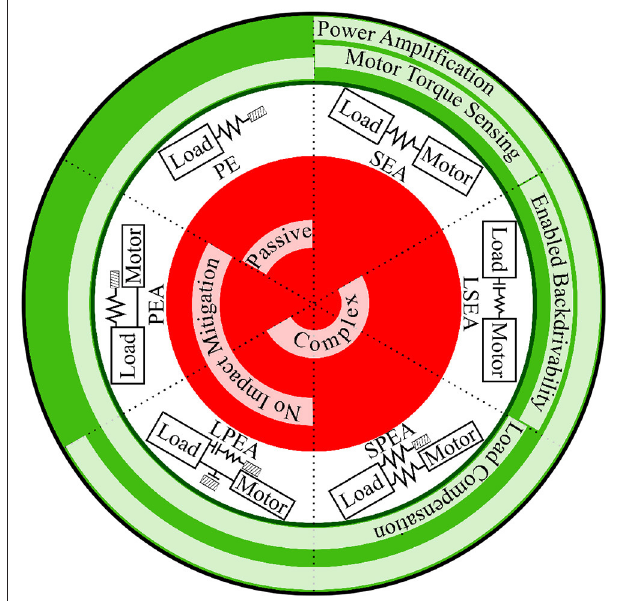
FIGURE 1 | A set of typical implementations of compliance in robotic joints, with main pros and cons shown in green and red respectively.